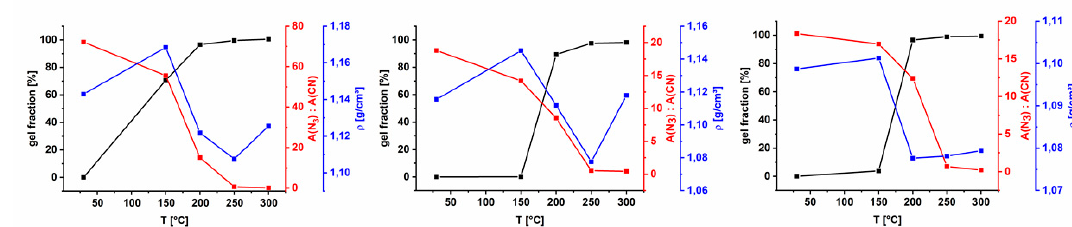
Figure 4. Results of gel fraction tests (black symbols), density measurements (blue symbols) and the ratio of band areas of nitrile group and azide group from FTIR (ATR) measurements (red symbols) at different crosslinking temperatures of AZ-PIM-100 (left), AZ-PIM-R50 (middle) and AZ-PIM-A50 (right).